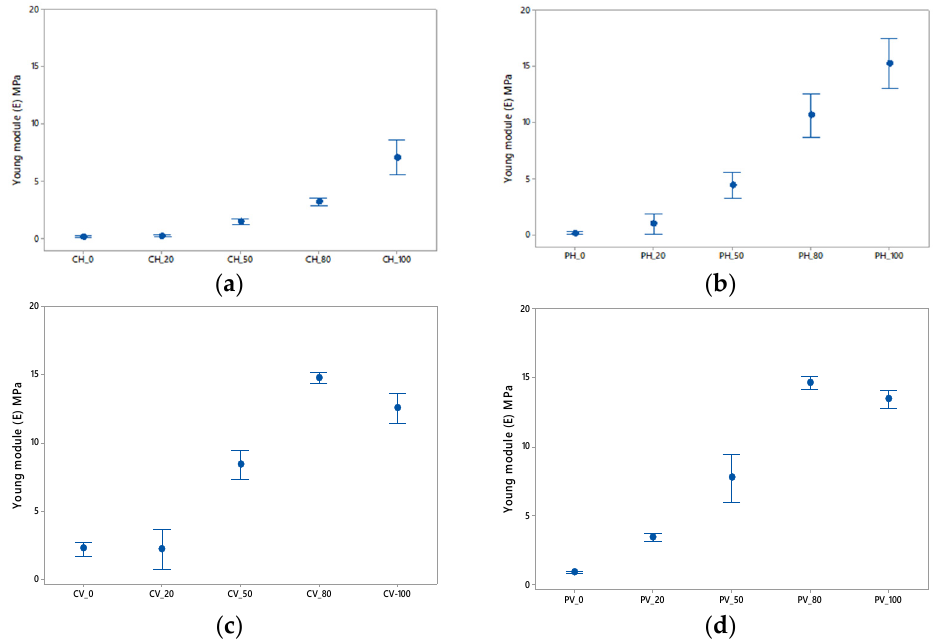
Figure 5. Elastic module according to the % of lightening: ( a , b ) horizontal orientation; ( c , d ) vertical orientation. ( a , c ) are cylindrical in shape and ( b , d ) are prismatic in